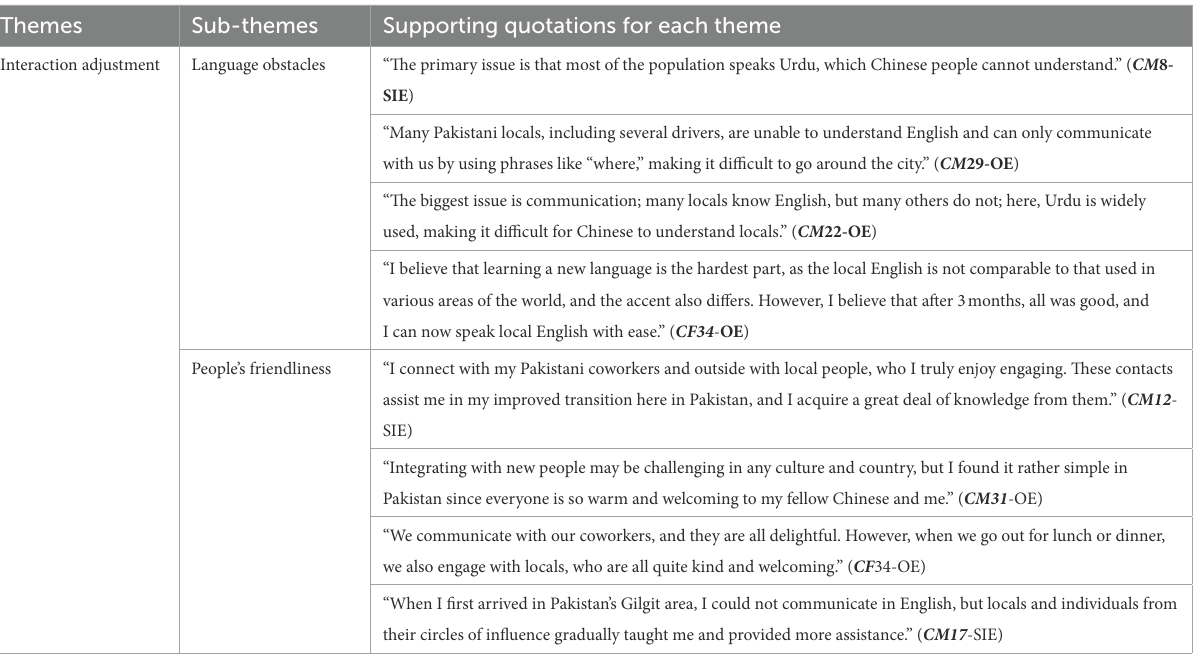
TABLE 3 Interaction adjustment themes and